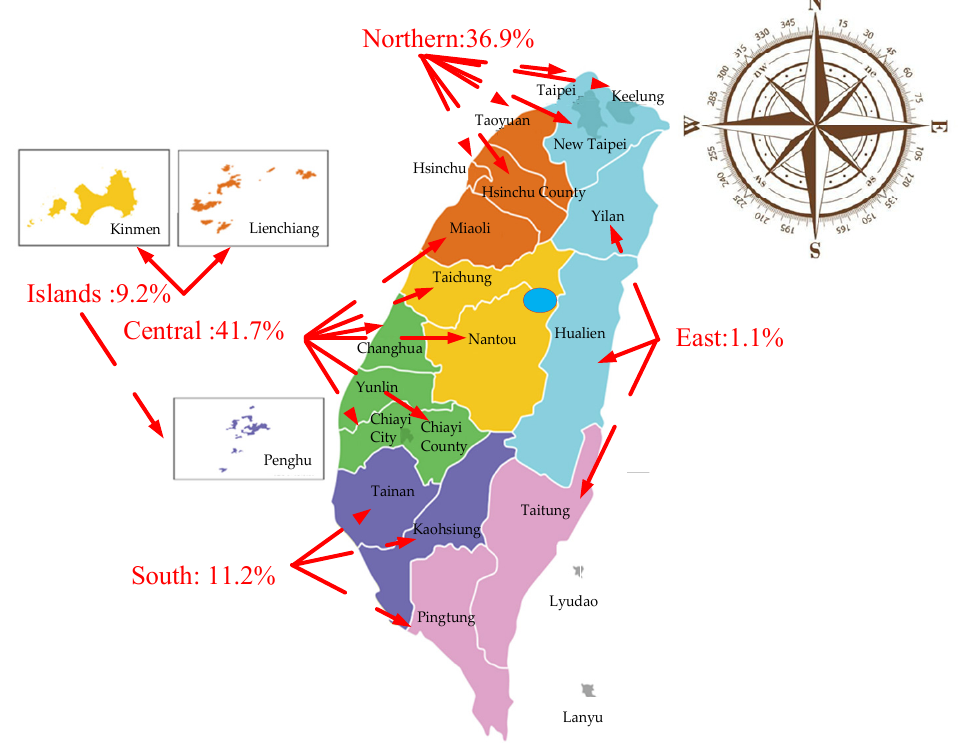
Figure 2. Distribution of sample